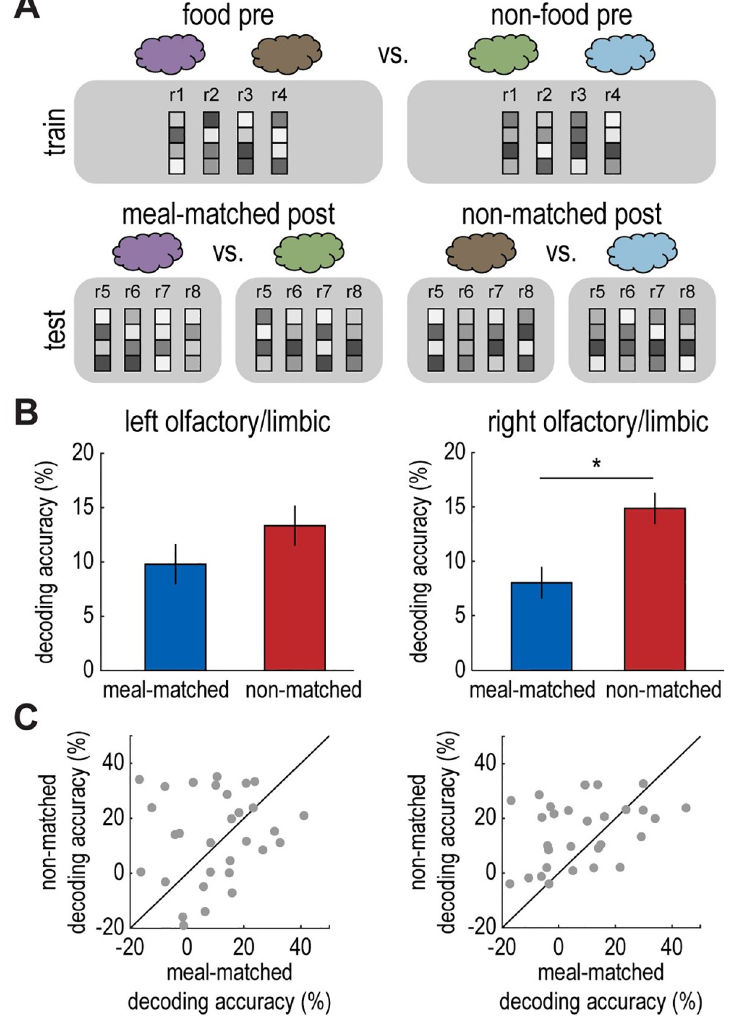
Fig 4. Satiety reduces fMRI pattern discrimination of the meal-matched odor pair. (A) Schematic of decoding analysis. An SVM classifier was trained to discriminate fMRI activity patterns evoked by pure food (average of cinnamon bun and pizza) vs. nonfood (average of cedar and pine) odors in the pre-meal session. The SVM classifier was tested on fMRI activity patterns evoked by pure odors in the post-meal session for meal-matched and non- matched conditions separately (cinnamon bun vs. cedar and pizza vs. pine). (B) In the right olfactory/limbic ROI ( Fig 3B ), food vs. nonfood decoding accuracy was significantly lower for the meal-matched odor pair compared to the non- matched odor pair in the sated state (t (29) = 2.35, p = 0.03; right). This was not the case in the left olfactory/limbic ROI (t (29) = 0.95, p = 0.35; left). (C) Individual participant data depicting post-meal decoding accuracy in the left and right olfactory/limbic ROIs for meal-matched vs. non-matched odor pairs. Error bars depict within-subject SEM for n = 30. Individual participant data summarized in these plots can be found in S1 Data . fMRI, functional magnetic resonance imaging; ROI, region of interest; SEM, standard error of the mean; SVM, support vector machine.